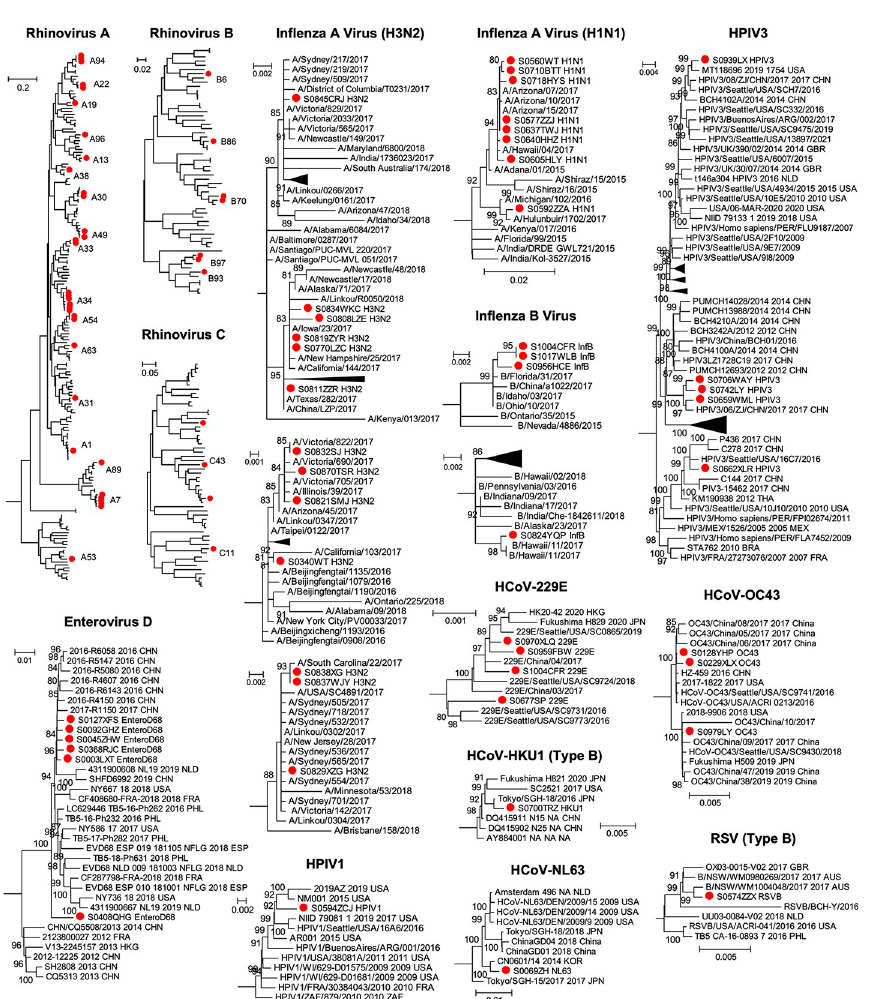
Fig 4. Evolutionary relationships of RNA virus pathogens identified in this study. Phylogenetic trees of each virus were estimated using the maximum likelihood method implemented in PhyML. Sequences identified from this study were marked with red solid circle. For larger trees, we only show the lineages or sub-lineages that contain sequences identified in this